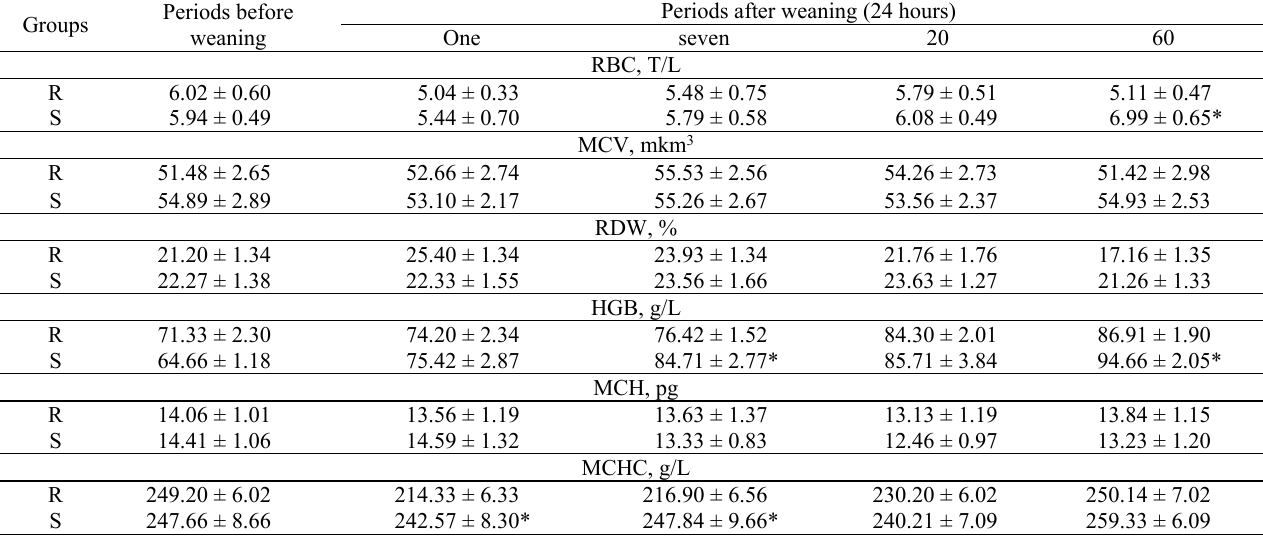
Periods after weaning (24 hours)